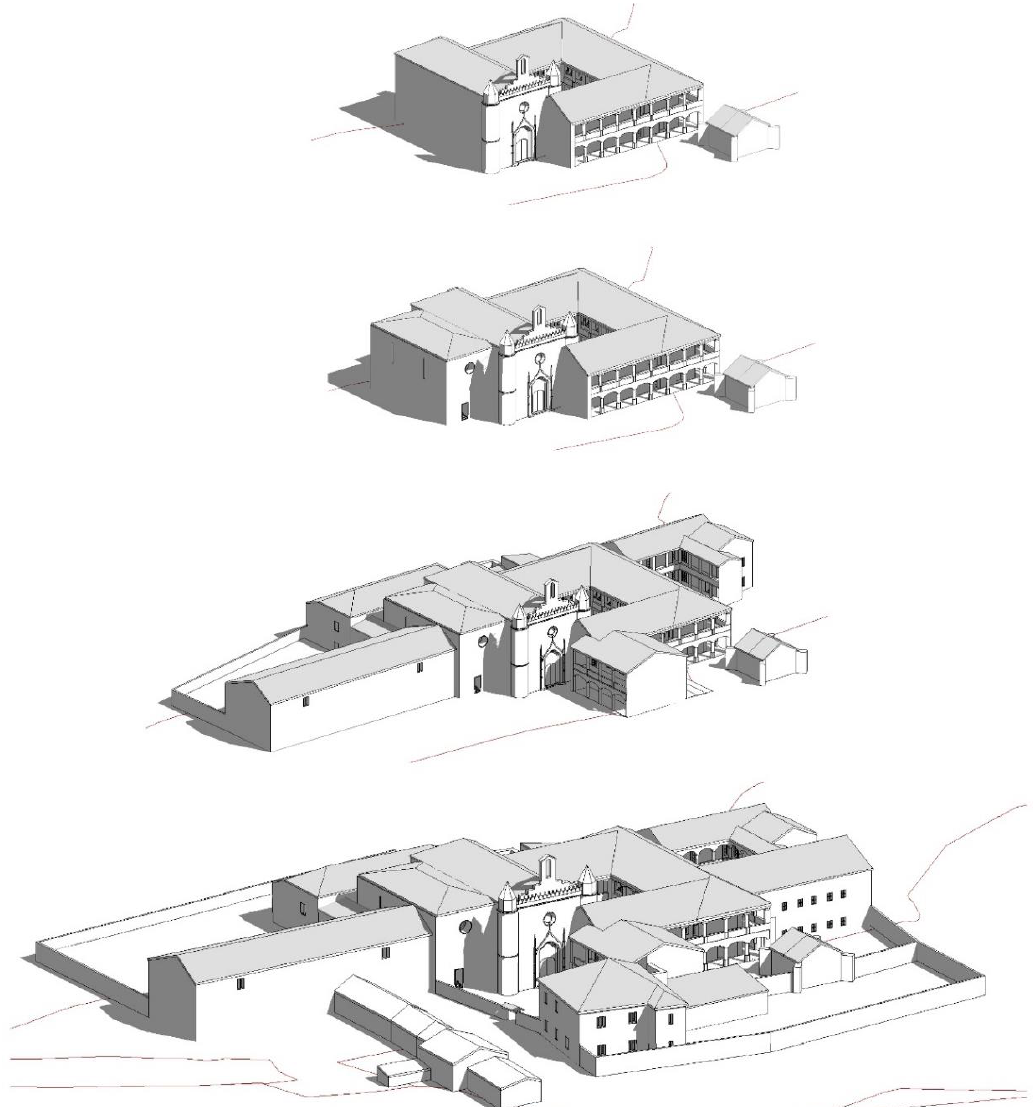
Figure 6. Architectural evolution of the monastic complex, 2021.